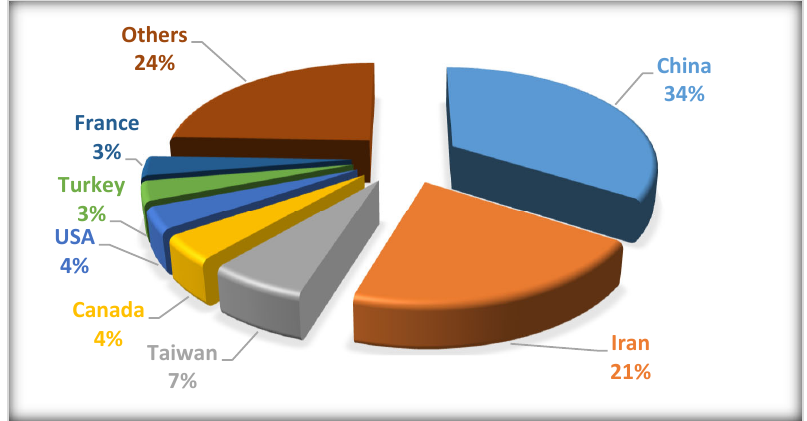
Fig.e 4. Percentage distribution of HFS articles according to